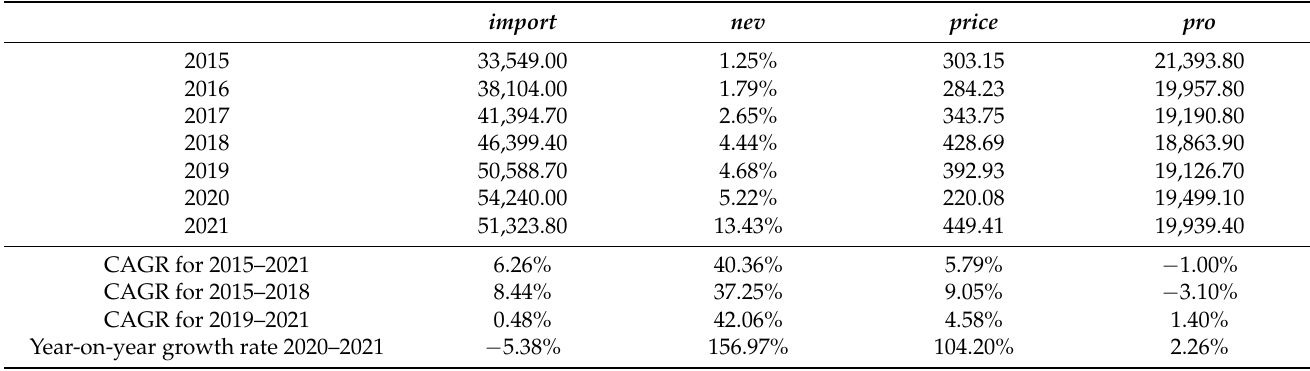
Table 3. Annual values of the variables and the compound annual growth rate over time.